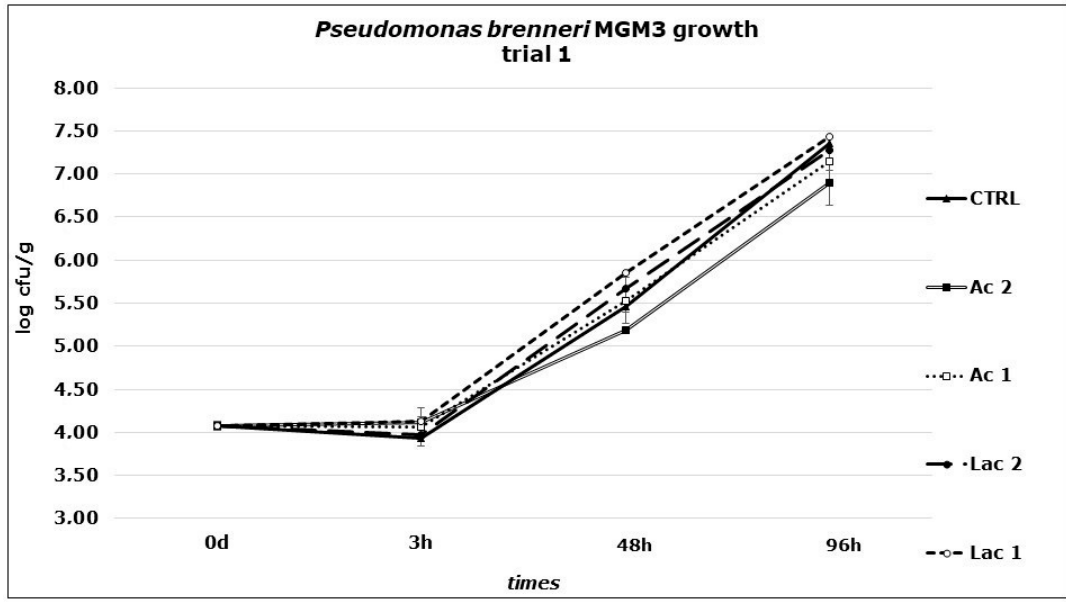
Figure 1. P. brenneri MGM3 counts obtained in Primo sale cheese during the first challenge test performed at 6 °C. Dipping: Ac1: acetic acid, 49.96 mM; Ac2: acetic acid, 99.92 mM; Lac1: lactic acid, 44.40 mM; Lac2: lactic acid, 88.80 mM; CTRL: distilled water.